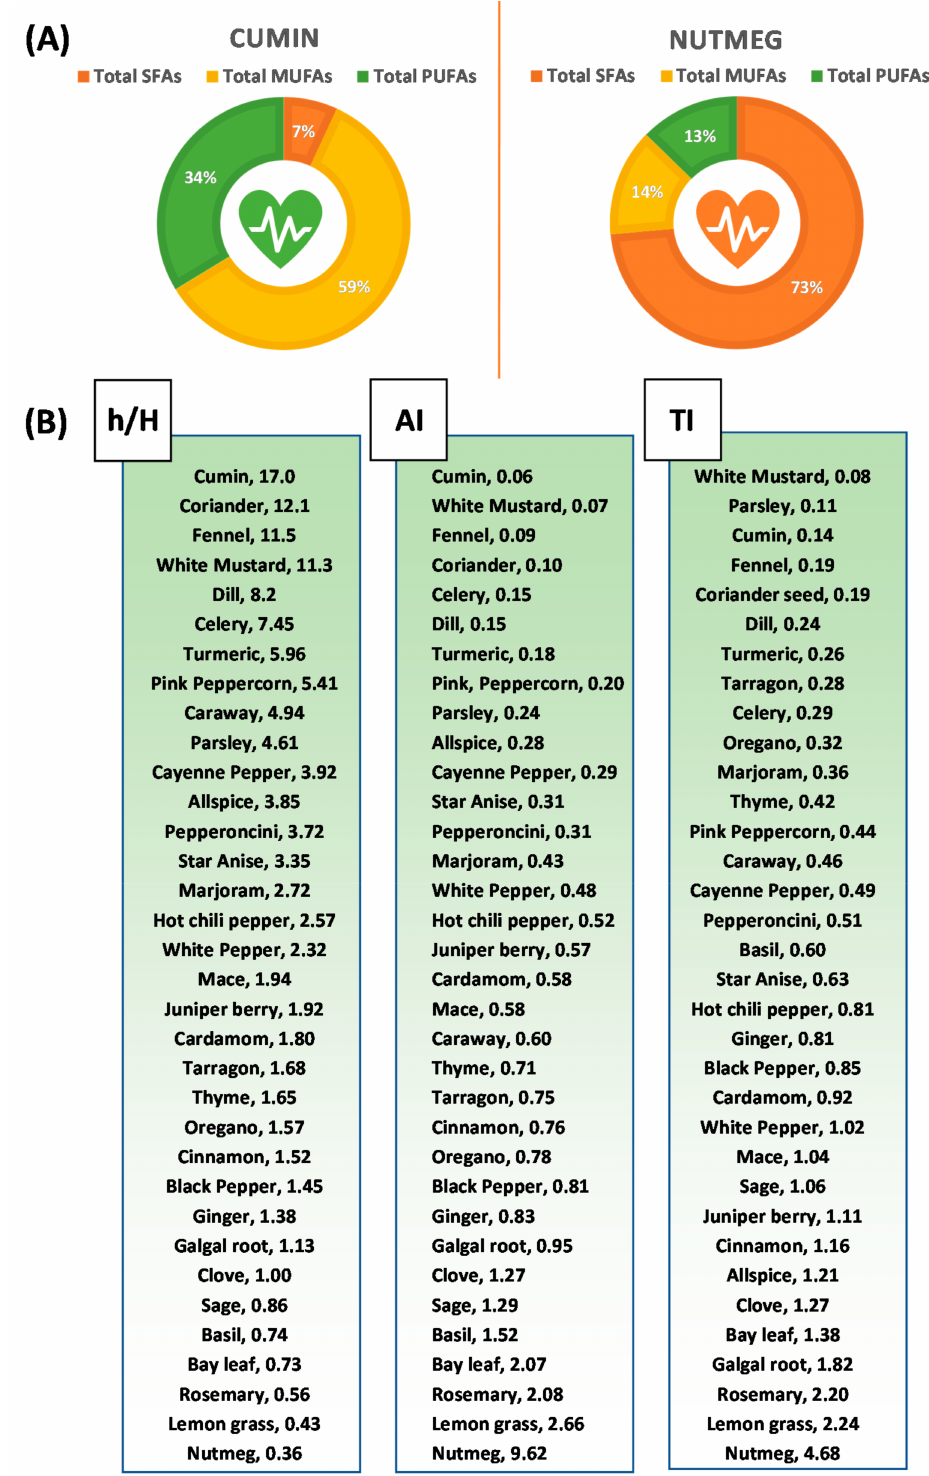
Figure 3. ( A ) Illustrations showing the high content of healthy monounsaturated (MUFAs) and polyunsaturated fatty acids (PUFAs) in cumin, compared to low contents of MUFAs and PUFAs, and high contents of saturated fatty acids (SFAs) in nutmeg. ( B ) Arrangements of studied spices and herbs in ascending/descending order according to the fat quality indices of the ratio of hypocholesterolemic (h)/hypercholesterolemic fatty acids, atherogenic index (AI), and thrombogenic index